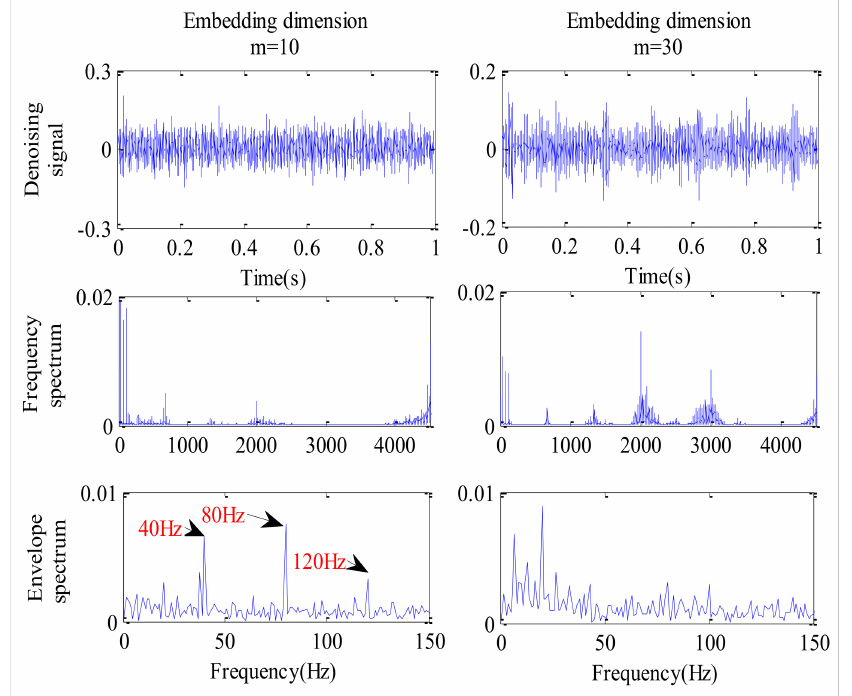
Figure 19. Denoising results of gear with breakage when embedding dimension m is set to 10 and 30,